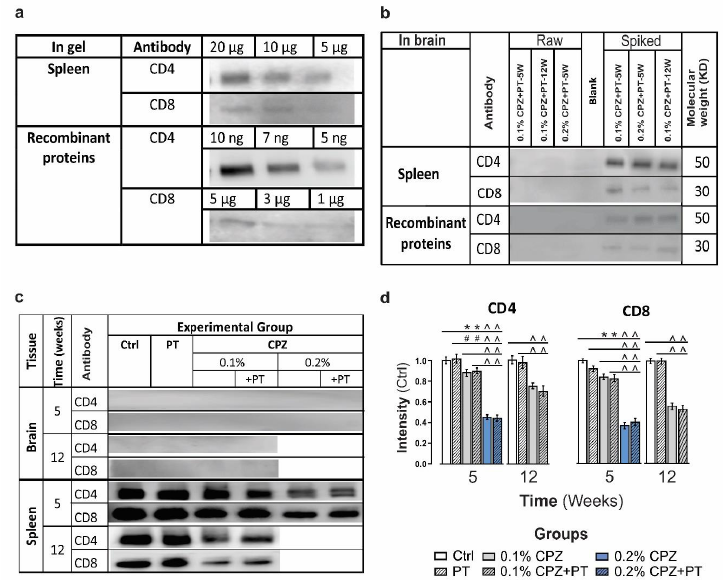
Figure 3. Western blot analysis. ( a ) Measurement of the detection limit of CD4/8 signal using naïve Ctrl spleen homogenates and CD4/8 recombinant proteins in gels. ( b ) Confirmation of CD4/8 signal detection using brain tissue samples (60 μg) spiked with either 5 μg or 10 μg of spleen homoge nate or 5 ng and 5 µg commercial CD4 and CD8 recombinant proteins. ( c ) No CD4/8 signal was detected in CPZ(±PT) brain samples whereas a reduced CD4/8 signal intensity was found in spleen. ( d ) Quantification of splenic CD4/8 blots showed a significant reduction of CD4 and CD8 signal intensity in spleens of specific groups. Cropped CD4/8 western blots are presented unaltered and shown in their entirety in Supplementary Figure S7. Data are presented as mean (±SEM) relative to the Ctrl mice. One-way ANOVA and Newman-Keuls Multiple Comparison post hoc analysis were used to determine differences among groups (* p < 0.05, # p < 0.01 and ^ p < 0.0001).